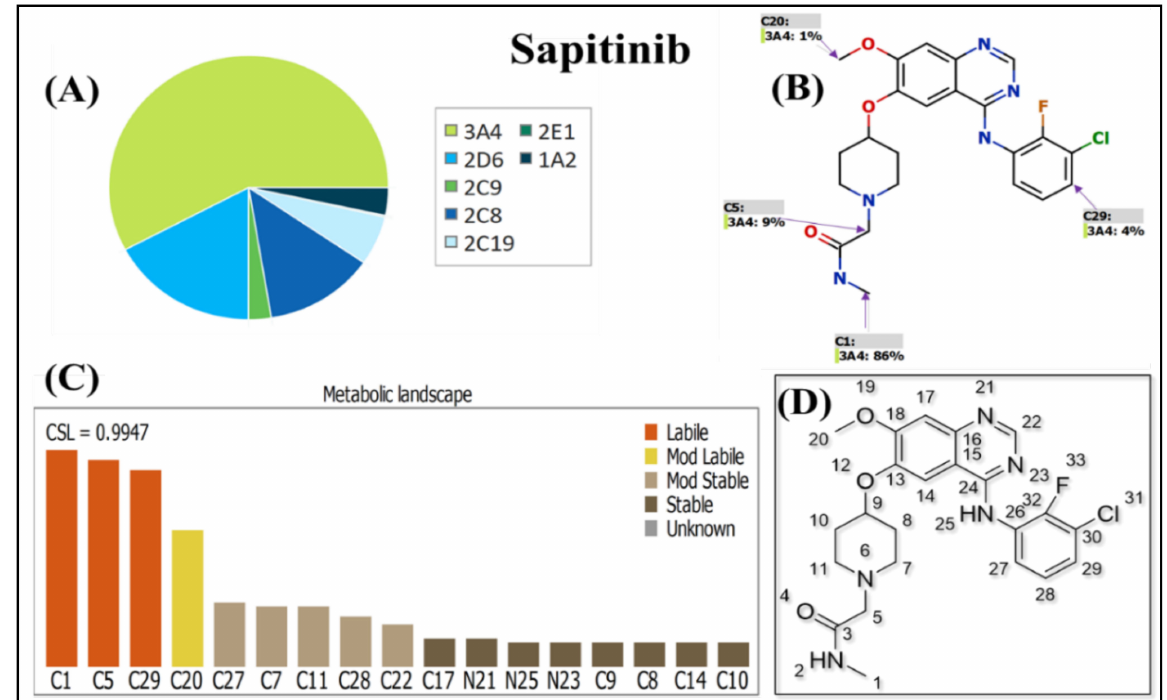
Figure 2. WhichP450 model prediction of major metabolizing isoform (CYP3A4) for SPT metabolism, as shown by pie chart ( A ). Regioselectivity map indicates predicted sites of metabolism for SPT ( B ). Metabolic landscape showing CSL of SPT (0.9797) revealed a high metabolic rate ( C ). Chemical structure of SPT with numbering system ( D ). These data were produced using StarDrop P450 metabolism